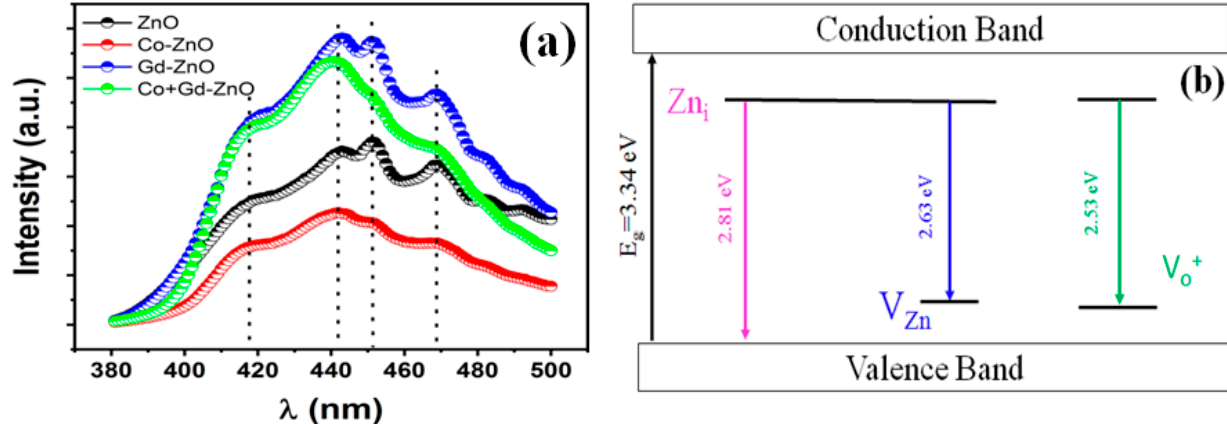
Figure 6. ( a )PL spectra of pure, Co-doped, Gd-doped, and Co/Gd di-doped ZnO;( b ) energy level Figure 6. ( a ) PL spectra of pure, Co-doped, Gd-doped, and Co/Gd di-doped ZnO; ( b ) energy level diagram of the defects states. diagram of the defects